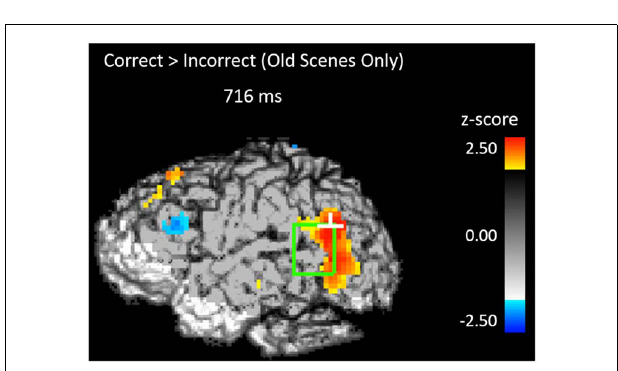
FIGURE 4 |Activity during the scene preview for subsequently correct trials vs. subsequently incorrect trials in the left STS at 716 ms. The light green rectangle indicates the STS ROI and the white cross marks the peak resel within the ROI.